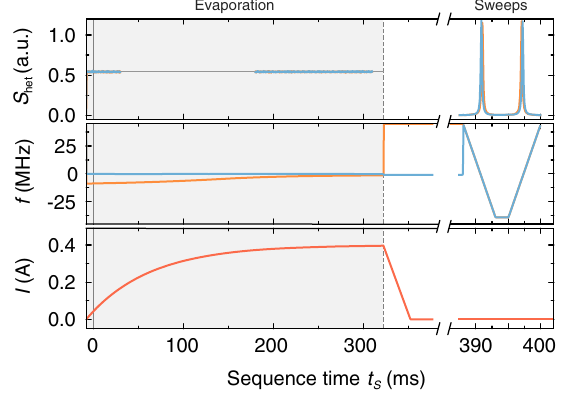
FIG. 5. Experimental sequence. Upper: heterodyne magnitude S with atoms present (not present) in orange (blue). The het heterodyne magnitude signal is not recorded for times t between s 30 and 170 ms. Middle: Corresponding VCO frequency f . Bottom: Current in our atomic chip wires (red). Evaporation is induced by ramping up the current, which lowers the trap depth dynamically (see Fig. 7), and halted at 320 ms by ramping the current back down quickly. During evaporation (indicated by gray shading in all panels), the heterodyne magnitude is kept constant by a side-of-fringe lock. The atom-induced cavity shift is extracted from an in-loop measurement of the control voltage fed back to the VCO. At the end of an experimental run, a swept atom-number measurement is performed, where δ is varied by pc sweeping f down and up across cavity resonance. In these sweep measurements, the atom number is extracted from the shift of the cavity profile visible in the heterodyne magnitude signal and is used just for calibration purposes.